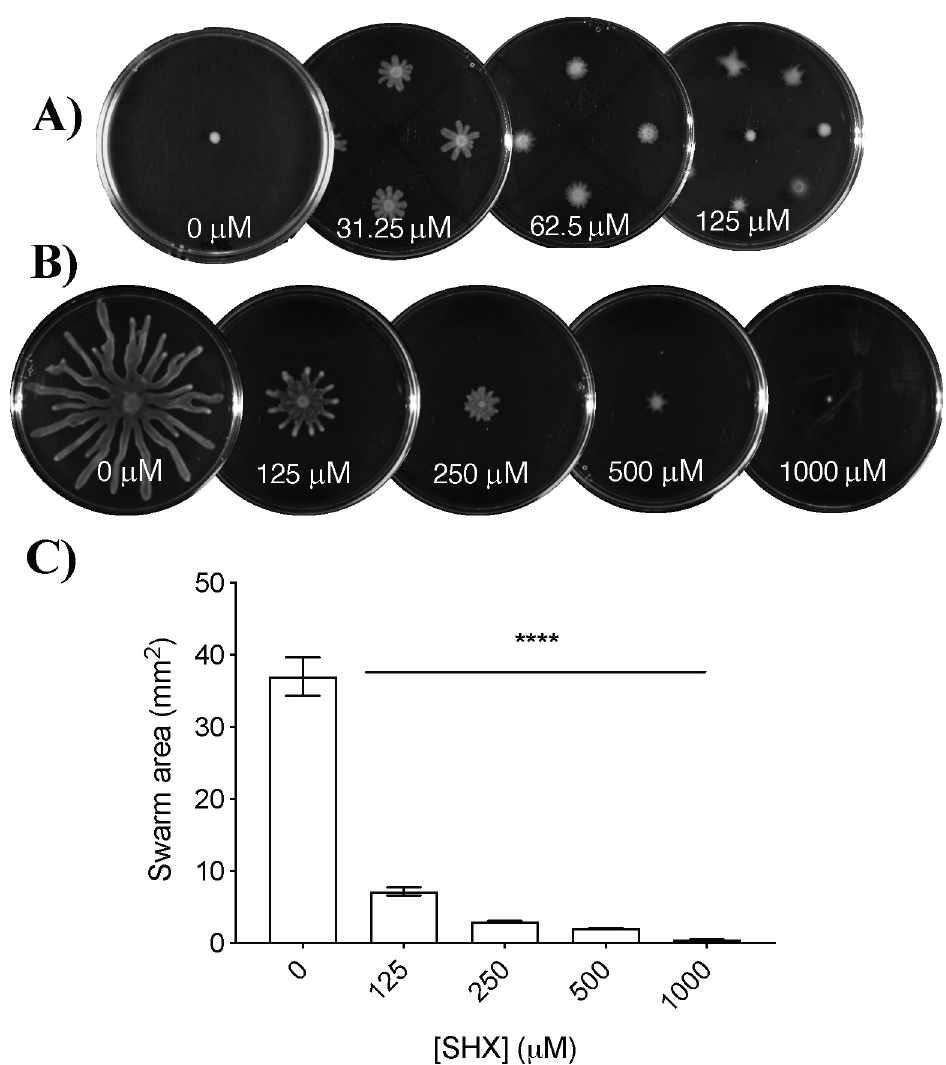
Fig 5. SHX partially restored swarming of peptide-inhibited cells in an inverse dose-dependent fashion and inhibited swarming of PA14 WT at higher doses. Briefly, BM2 swarm plates ( ± 0.75 μ g/ml 1018) were inoculated with 1 μ l of planktonic cells suspended at an OD 600 of 0.4–0.6 in BM2 and then incubated for 20 h at 37˚C. The stringent stress response ((p)ppGpp production) was induced by supplementing swarm medium with SHX. (A) Peptide 1018 was antagonized by treatment with SHX at a low concentration (31.25 μ M). (B) In the absence of peptide, SHX partially inhibited swarming at 125 μ M. (C) Swarm colony area of SHX-treated cells (in the absence of peptide 1018). Mean and standard error of the mean are shown. One-way ANOVA followed by Dunn’s correction was used to determine statistical significance. ���� P < 0.0001. Each experiment had at least three biological